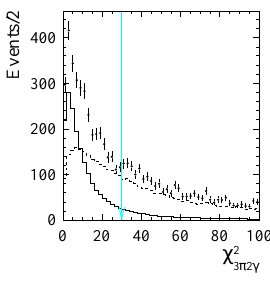
Figure 1. The χ 2 Figure 2. The spectrum of the two-photon invari- distribution for selected data 3 π 2 γ events (points with error bars). The solid and dashed ant mass of the η -meson candidate for selected data histograms represent the shapes of signal and back- events (points with error bars). The solid histogram ground e + e − → π + π − π 0 π 0 distributions obtained us- is the result of the fit to the data spectrum with a ing MC simulation, respectively. The arrow indicates sum of signal and background distributions. The < 30. the boundary of the condition χ 2 background distribution is shown by the dashed his- 3 π 2 γ togram. The dotted histogram represents the e + e − → π + π − π 0 π 0 background